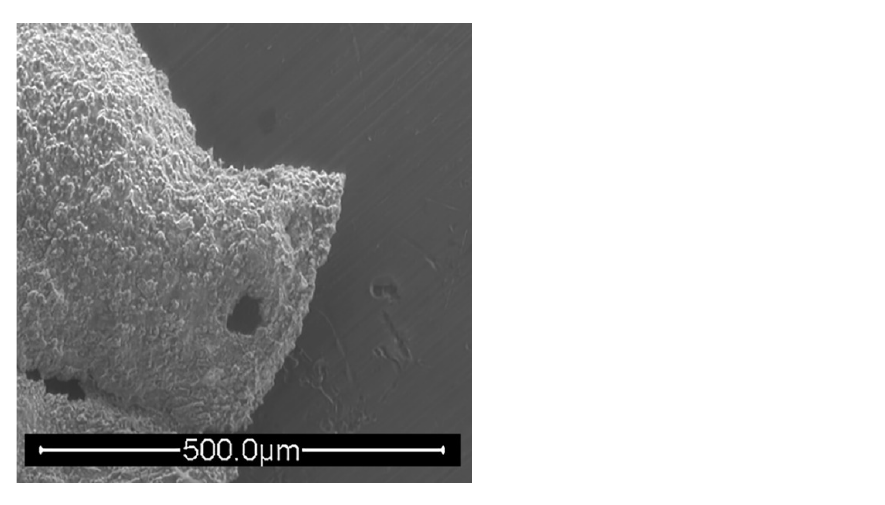
Figure 9. Ceratobairdia sp., right valve, lateral view. IGM 5011(6). Width of valve 1.2 mm. Image credit: Mark McMenamin.